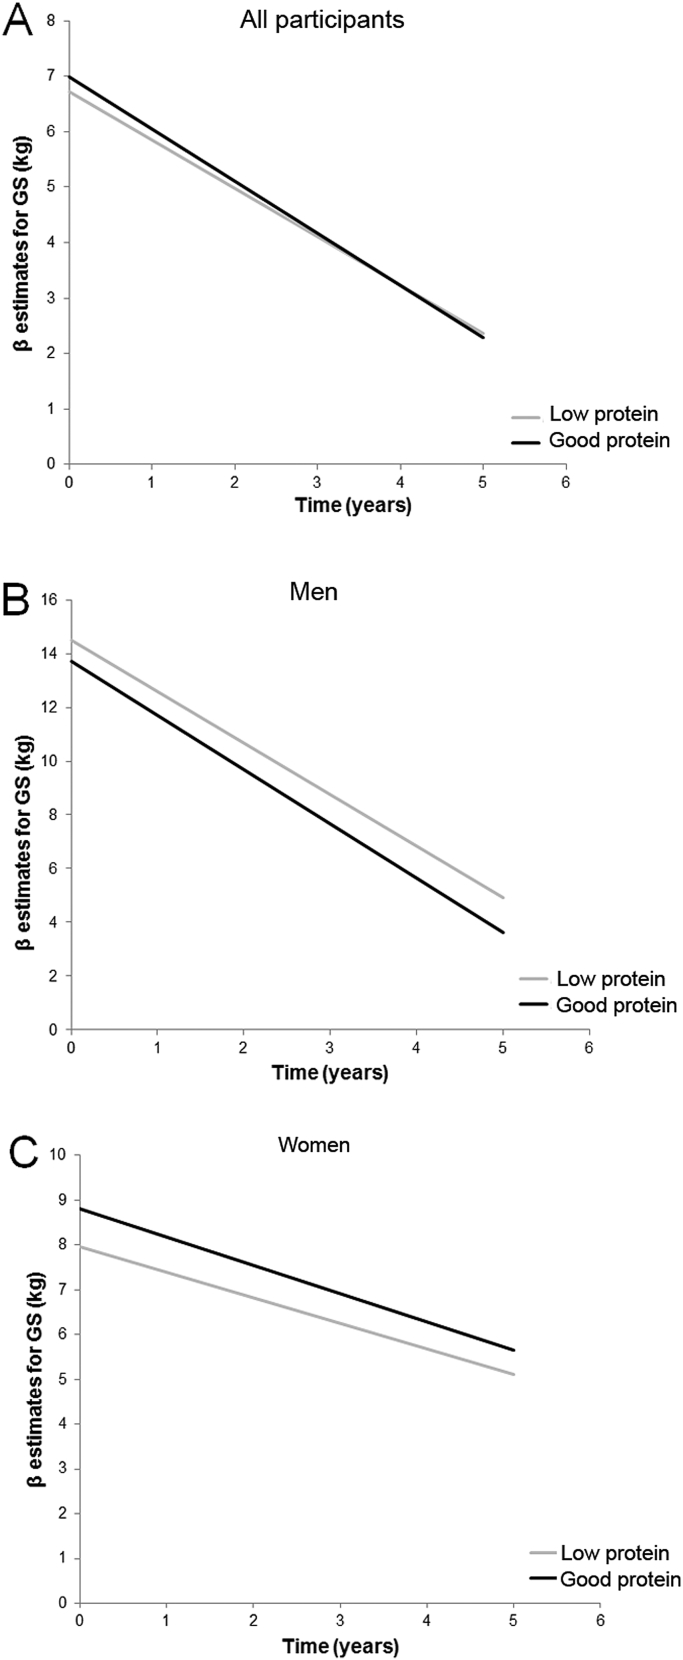
A similar rate of decline in GS by protein intake. We found no association between low protein intake (<1 g/kg aBW/d; grey line) and grip strength (GS) at baseline or GS decline compared with good protein intake (≥1 g/kg aBW/d; black line) in all participants (panel A) and in men (panel B). In women (panel C), low protein intake (grey line) was associated with lower GS at baseline, but not with the rate of GS decline over 5 years. The growth curves represent β estimates of the fully adjusted model (Model 3). Greater β estimates indicate higher muscle strength (GS).